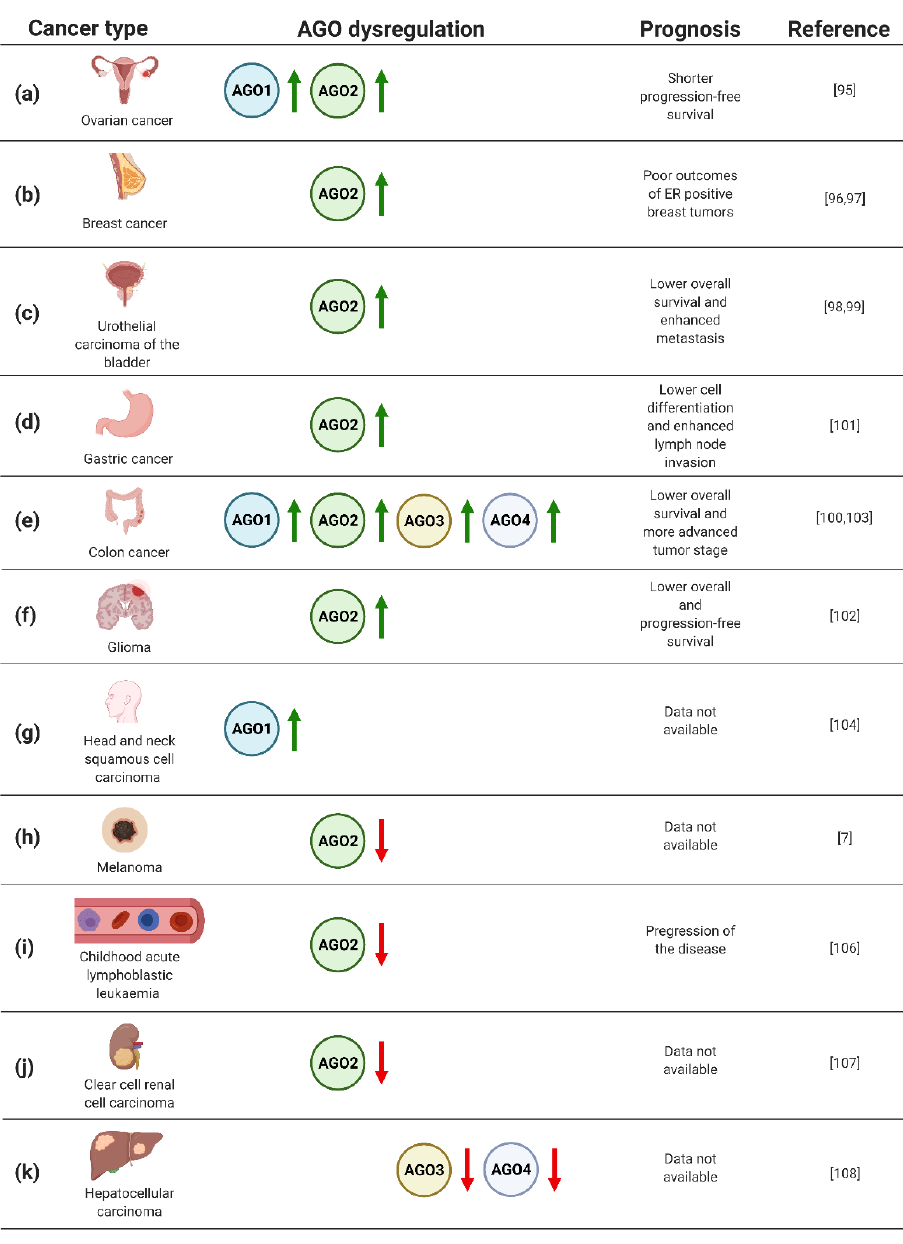
Figure 3. ( a – k ) Dysregulation of AGO1–4 in cancers, based on refs [7,95–108]. Created with BioRender.com (accessed date: 21 January 2021).